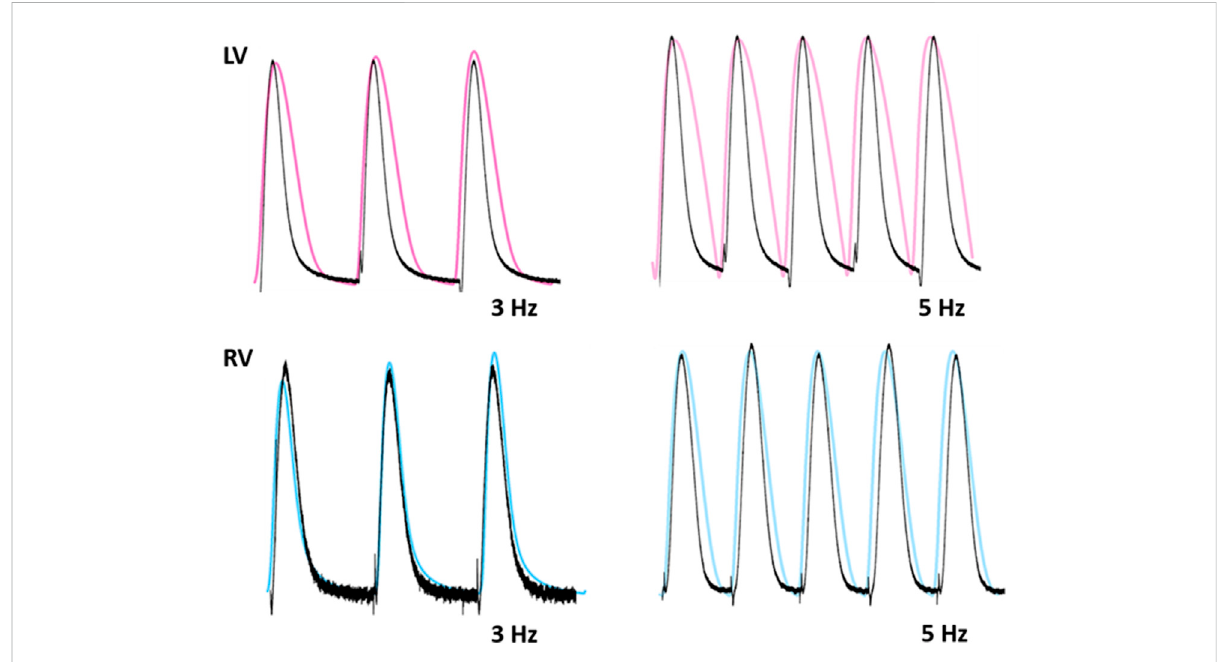
FIGURE 15 Comparison of traces for normalized tension between LV and RV myocytes at stimulations rates of 3 and 5 Hz (Kim, 2018). Black lines: experimental data. Colored lines: simulated